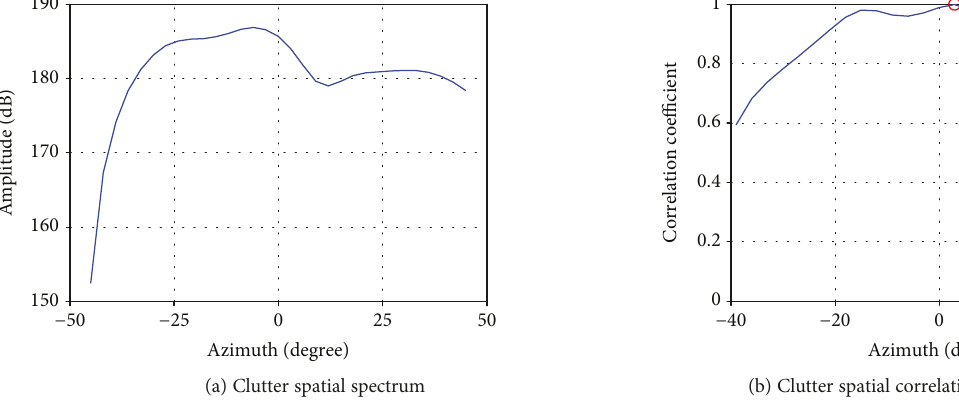
Figure 6: Clutter spatial characteristics.